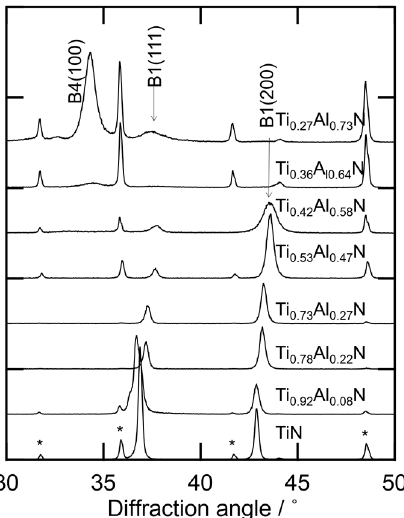
Figure 4. X-ray diffraction patterns of AIP-deposited TiN and TiAlN coating with different Al compositions. Compositions show composition of coating. Marks * denote diffraction peaks from the substrate.